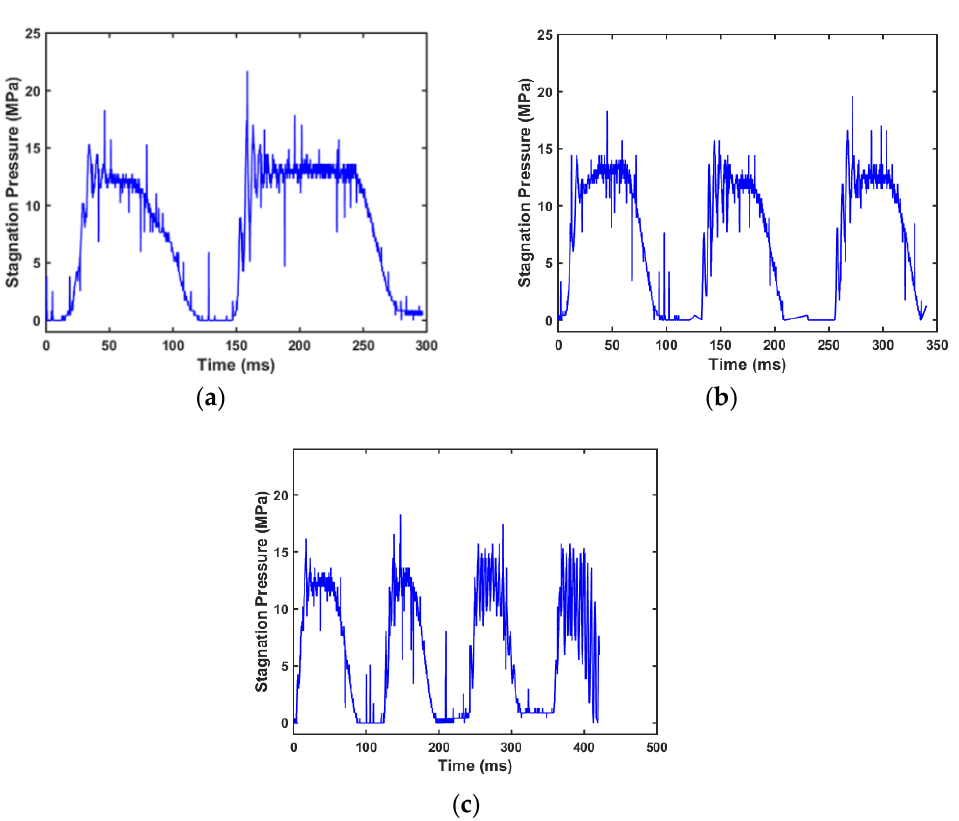
Figure 16. Results showing the capability of the present prototype to shape the pressure profile and deliver different multiple pulse injections: ( a ) two pulses, ( b ) three pulses and ( c ) four pulses. The pulsed injections in each case were delivered at a frequency of approximately 10 Hz, and each pulse was approximately 0.2 mL of